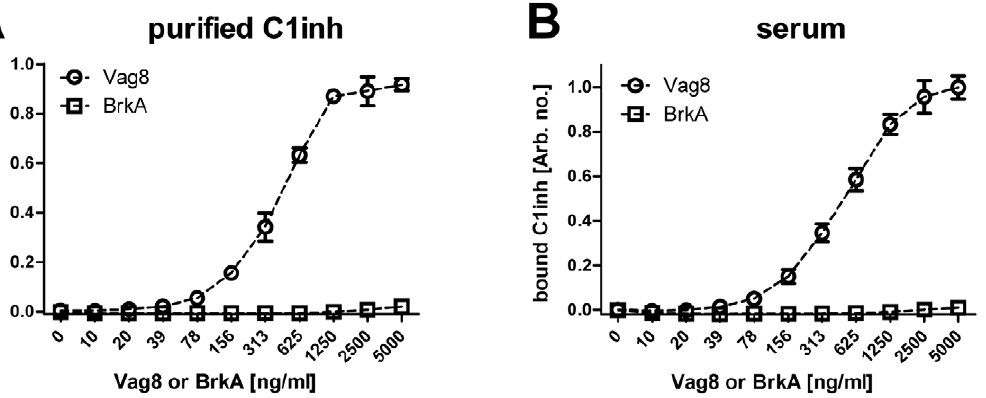
Figure 4. Purified histidine-tagged Vag8 passenger domain binds C1inh. Shown are means 6 SD of a representative ELISA done in triplicate, where Nunc MaxiSorp H flat-bottom 96 well plates were coated with increasing two-fold concentrations of purified histidine-tagged Vag8 passenger or purified histidine-tagged BrkA passenger, and after blocking non-specific binding, incubated with either 10 m g/ml purified C1inh ( A ), or 2% normal human serum diluted in 1 6 Veronal buffer ( B ). For each graph shown, two independent experiments were done.